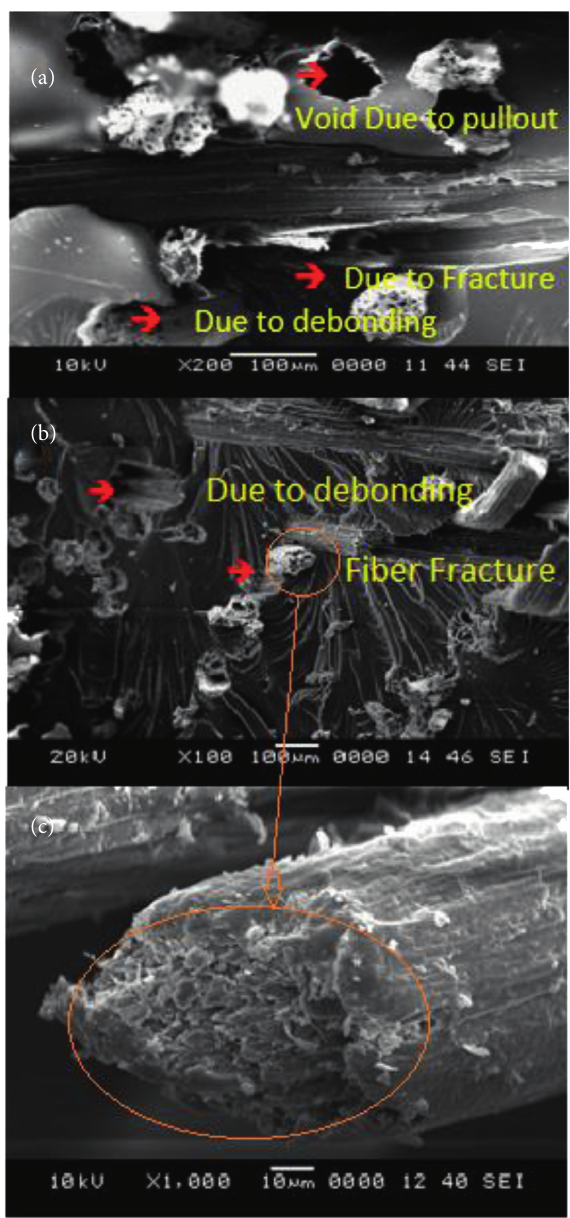
Figure 10: Tensile test: (a) untreated fiber with polyester; (b, c) CaCO